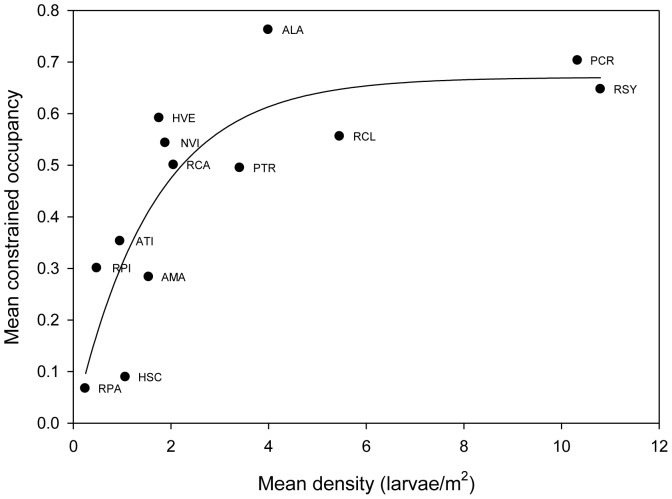
Constrained interspecific distribution-abundance relationship for the ESGR amphibians.The dependent variable is the average fraction of potentially habitable ponds occupied fit to the relationship, y = a(1−bx), R2 = 0.70, F1,11 = 28.6, p = 0.0002. Species designations as in Figure 1.